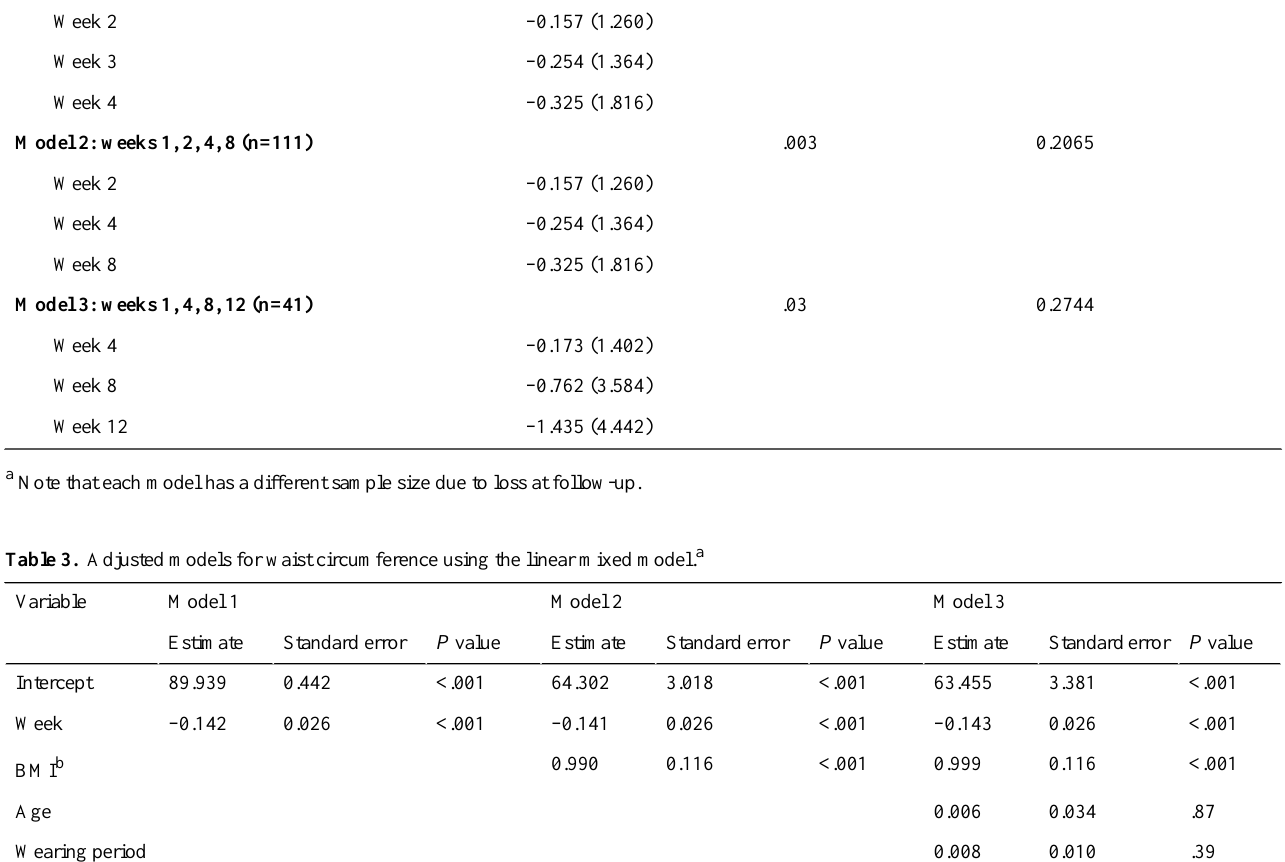
Cohen fP valueDifference from baseline, mean(SD)Model